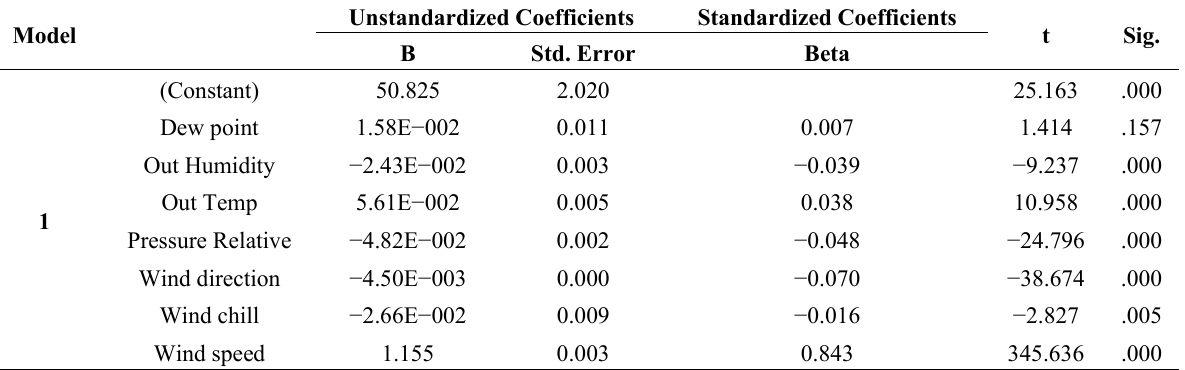
Table 6. ( a ) Regression of the weather data studied using all seven input variables against real gust as output. Regression test results show all input variables except for dew point ( p − value = 0.157) as predictors (at p − value < 0.05 ) and with 0.733 adjusted R square. ( b ) PCA results of the weather data studied using all seven input variables against real gust as output. Regression test results show all input variables except for dew point ( p − value = 0.157) as predictors (at p − value < 0.05 ) and with 0.733 adjusted R square.